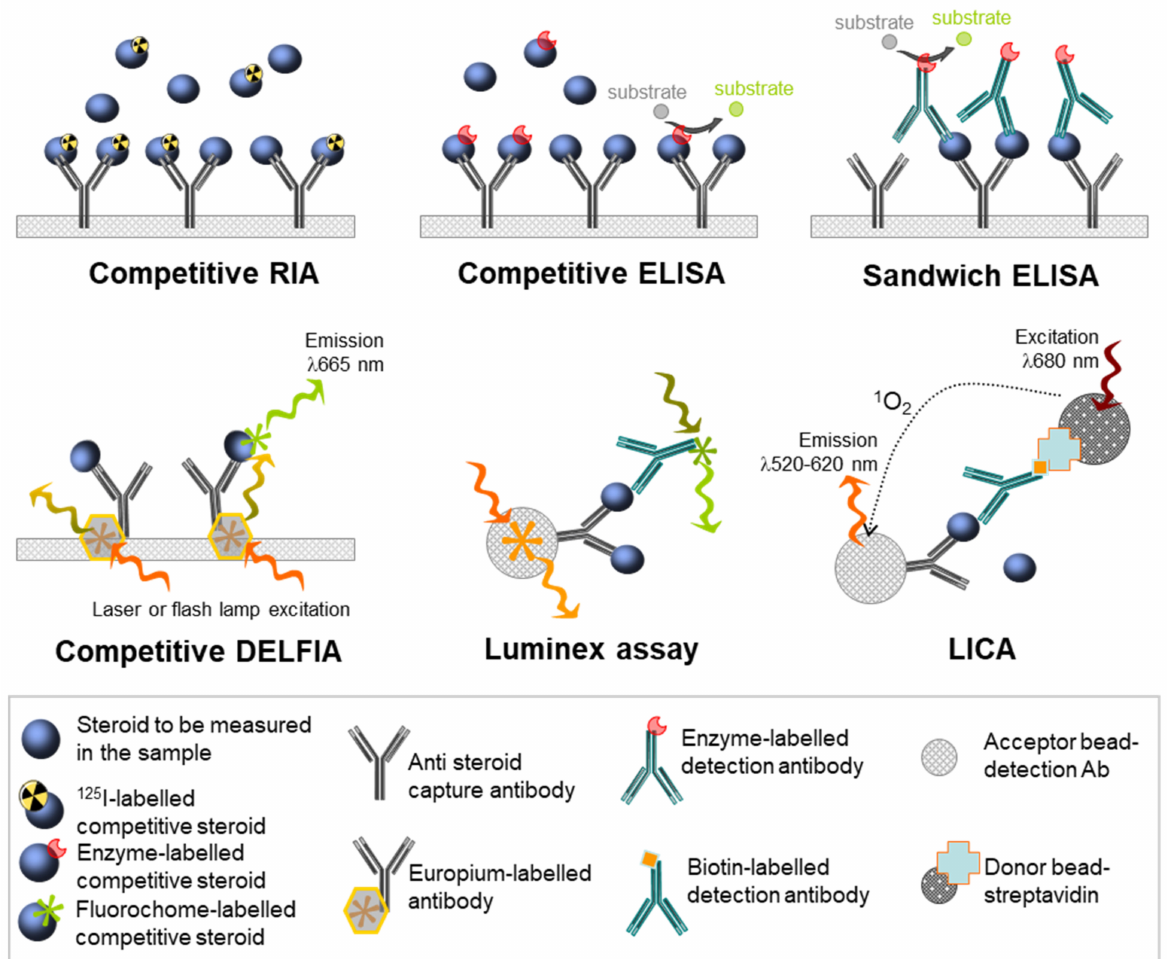
Figure 3. A schematic explanation of the principal immunological assay types. All the immunological methods represented here rely on the use of a steroid-directed specific detection antibody fixed on a solid phase or on beads. The main difference lies in the detection technique. The steroid of interest-antibody complex will be detected even by a radioactive competitor (radioimmunoassay; RIA), or an enzymatic reaction (Enzyme Linked ImmunoSorbent Assay; ELISA), fluorescent dyes (Dissociation-enhanced lanthanide fluorescence immunoassay; DELFIA, Luminex technology), or chemiluminescent dyes (light-initiated chemiluminescent assays; LICA). The main components for each technology are described in the